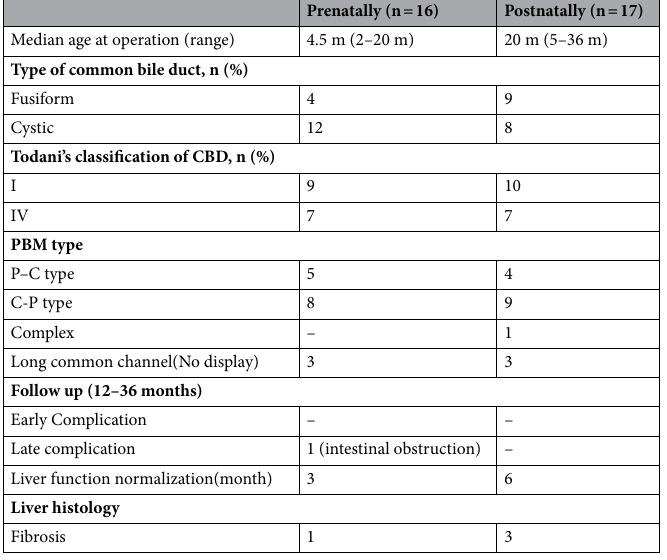
Table 1. Information on age at operative, anatomy, and the liver histology and a longer follow-up of